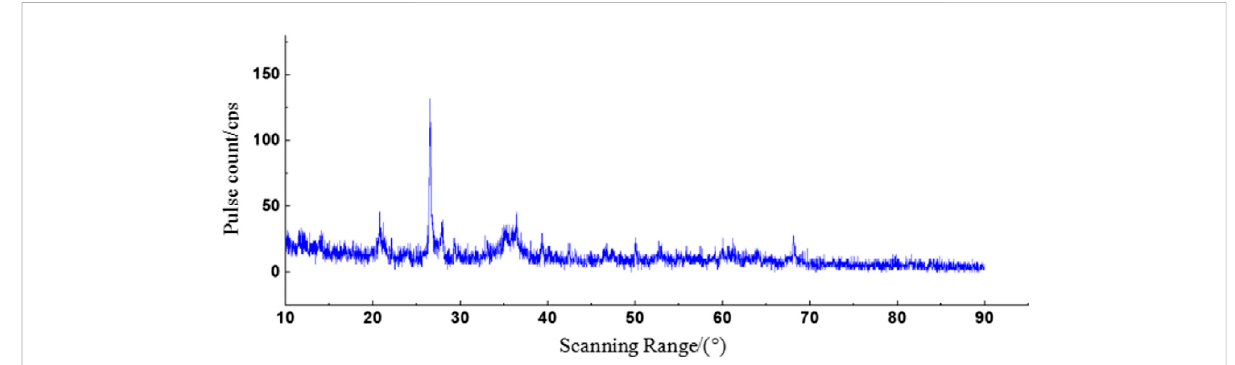
FIGURE 7 XRD pattern of specimen No. 2.